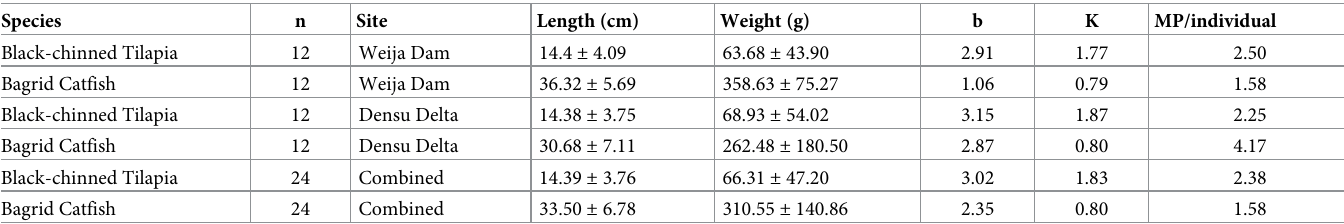
Table 1. Morphometric, growth coefficients and condition factors of Bagrid Catfish and Black-chinned Tilapia specimens from Densu Delta and Weija Dam.